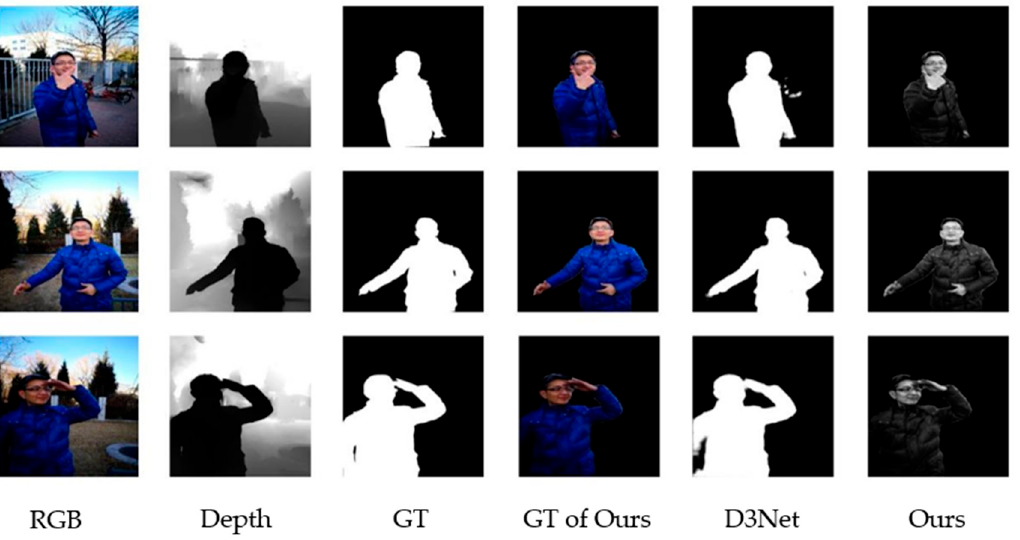
Figure 5. Visual comparison of the SOD methods and the SOD methods, based on specific object imaging on small sample datasets.